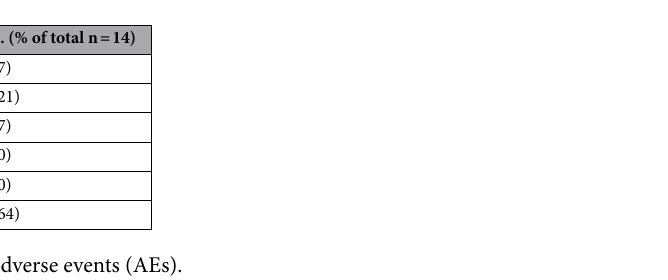
Table 2. Patients (%) reporting adverse events (AEs).